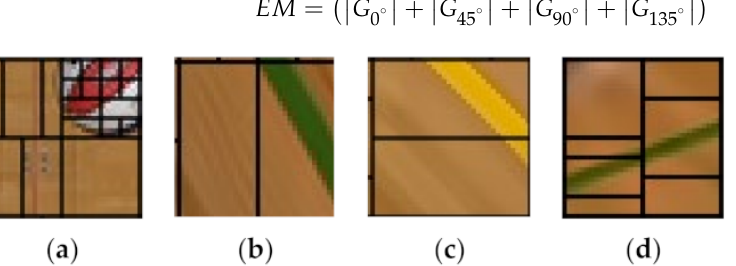
Figure 5. Example of CU partition related to CU texture: ( a ) example of QT split related to textures; ( b ) example of BTV split related to textures; ( c ) example of BTH split related to textures; ( d ) example of TT split related to